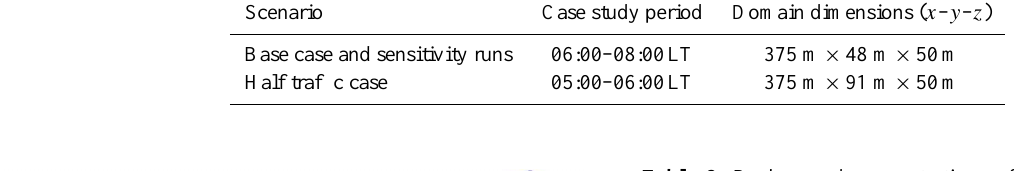
Table 3. Background concentrations of particulate and gaseous species considered in the